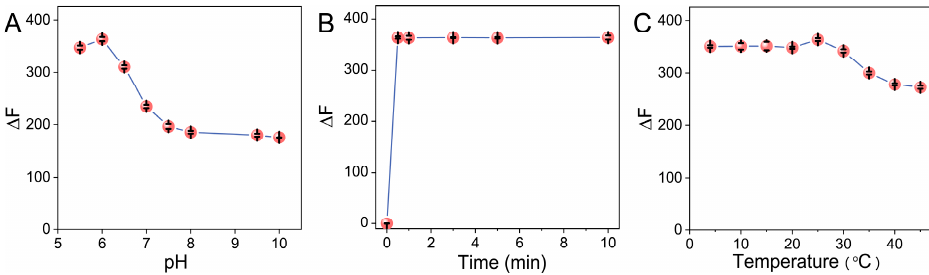
Figure 3. Influences of ( A ) solution pH, ( B ) incubation time, and ( C ) incubation temperature on the proposed AQ4N sensing system. The concentration of AQ4N is 0.5 μ M.